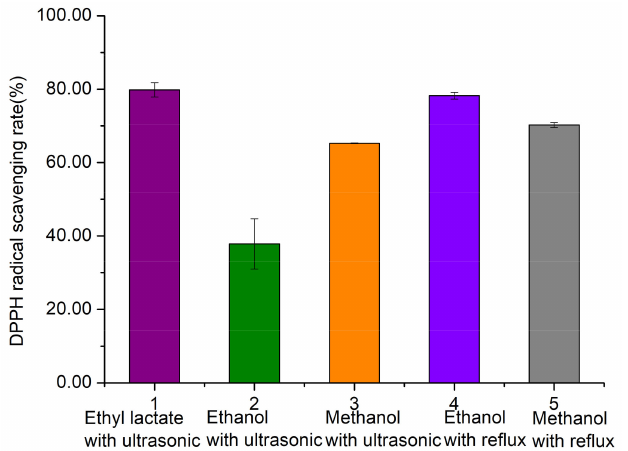
Figure 3. The DPPH radical scavenging abilities of lotus seed epicarp extracts obtained by different extraction